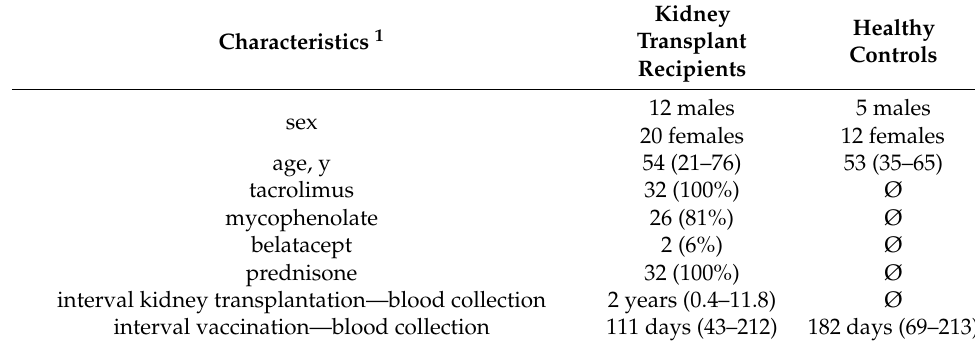
Table 1. Overview of the study